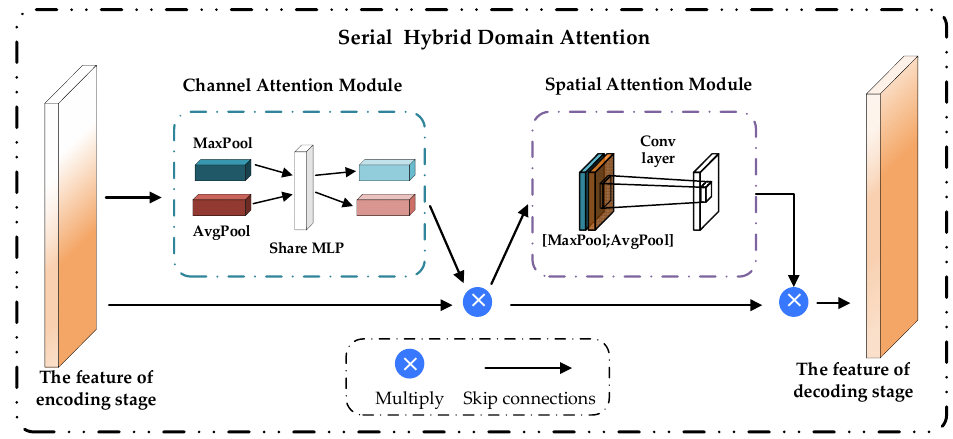
Figure 2. Structure diagram of the serial hybrid domain attention (SHDA).